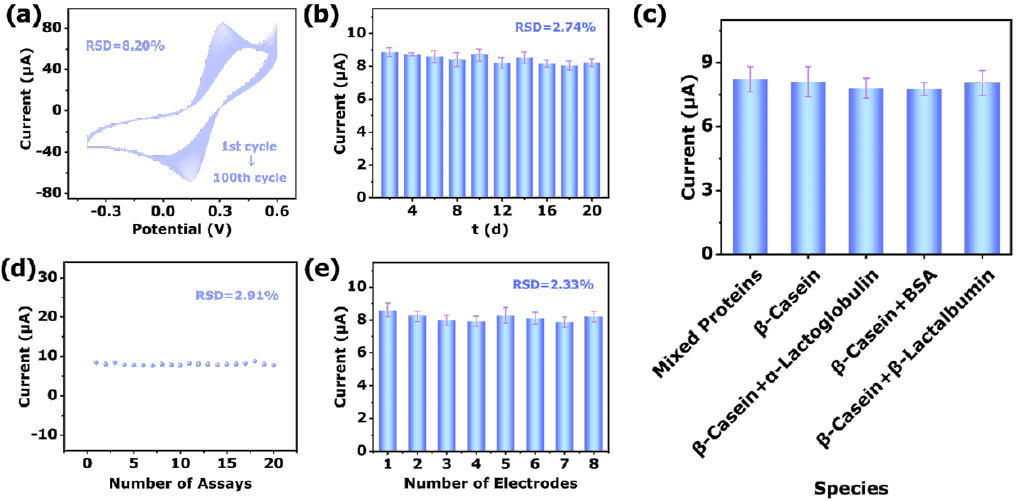
Figure 7. ( a ) Repeat the cycle 100 times of MT-600 ℃ /GCE at 100 mV/s in in 5.0 mM [Fe(CN) 6 ] 3-/4- containing 0.1 M KCl. ( b ) CV responses current histogram of MT-600 ◦ C/GCE in artificial sweat (pH = 7.0) containing1 mg/mL β -Casein in 20 days. ( c ) Selectivity studies of CV responses MT-600 ℃ /GCE. ( d ) Repetitive CV responses current histogram of MT-600 ℃ /GCE with one elec- trode for 20 times. ( e ) CV responses of MT-600 ℃ /GCE for eight parallel electrodes.